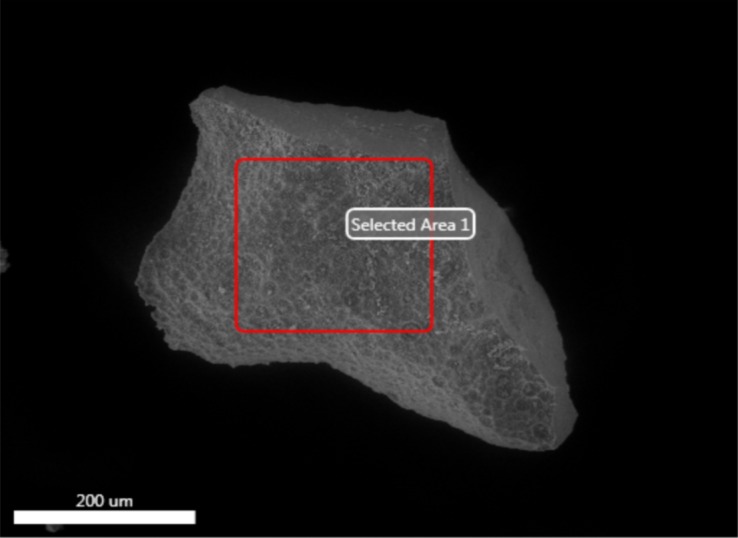
Electron image of mineral grain from demineralised Late Cretaceous Centrosaurus bone area A.